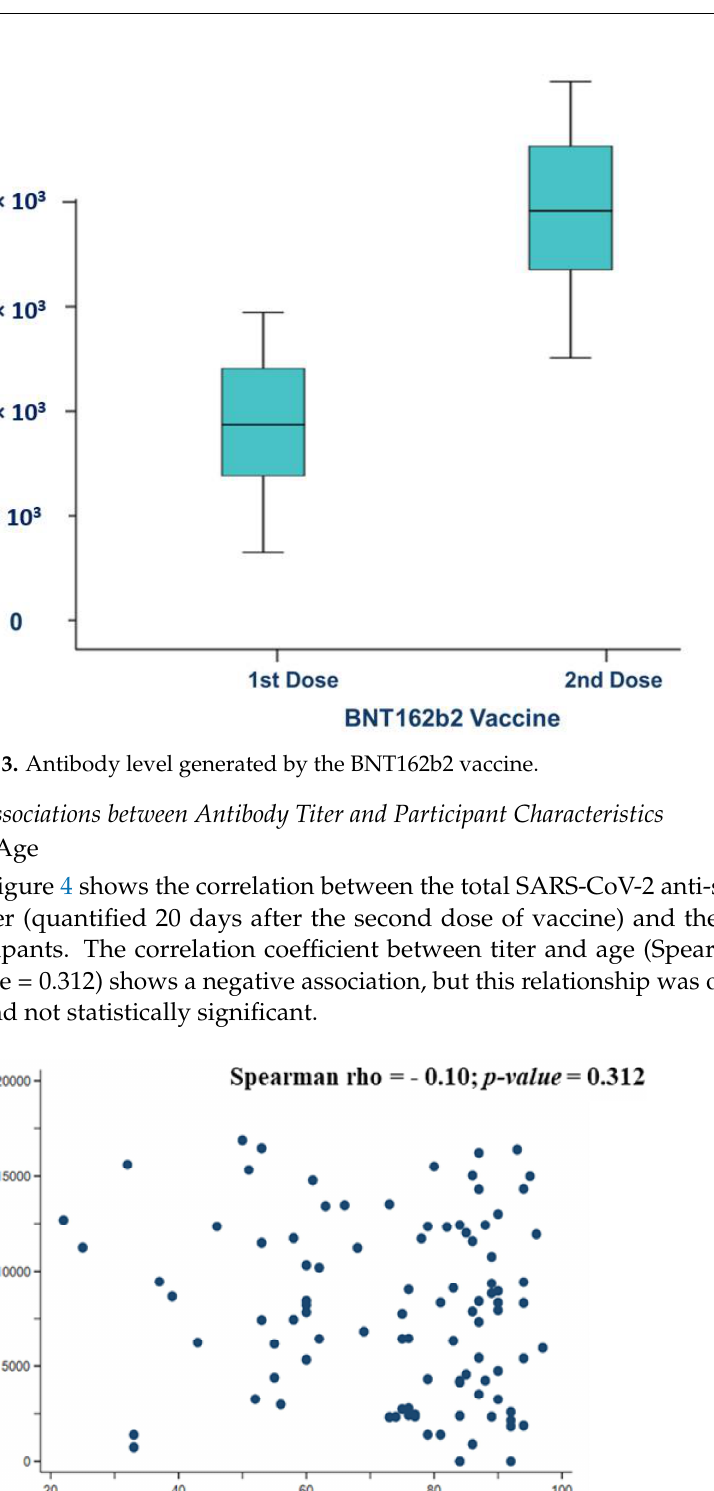
Figure 5. Correlation between total SARS-CoV-2 anti-spike IgG antibody titer (AU/mL) quantified 20 days after administration of the second dose of vaccine and body mass index of participants. 3.7.3. Number of Drugs and Specific Treatments The association between total SARS-CoV-2 anti-spike IgG antibodies titer and the number of drugs was evaluated, and an extremely weak negative correlation without statistical significance was observed (Spearman rho = −0.07, p -value = 0.490). Further- more, the comparative analysis through the nonparametric test of two independent samples (Mann–Whitney U) showed that there were no significant differences between participants with antihypertensive ( p -value > 0.05), immunosuppressant ( p -value > 0.05), antidiabetic ( p -value > 0.05), and lipid-lowering ( p -value > 0.05) treatment and those par- ticipants without the prescription of these treatments (data not shown graphically).